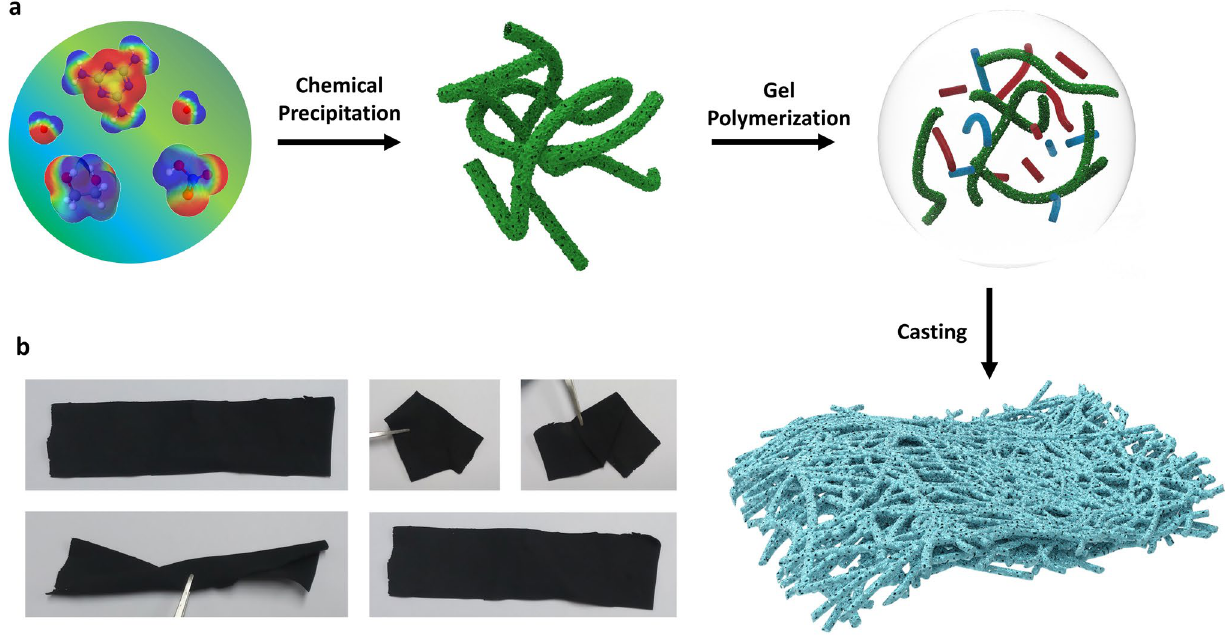
Fig. 1 Design illustration for free‑standing metal‑free catalysts. a Schematic process of supramolecular polymer‑incorporated nitrogen‑defi‑ cient carbon–nitrogen frameworks (PEMAC@NDCN) free‑standing membrane catalysts. Note the red and blue shapes define the guanosine and PEMAC molecules. b The snapshots of flexible free‑standing PEMAC@NDCN